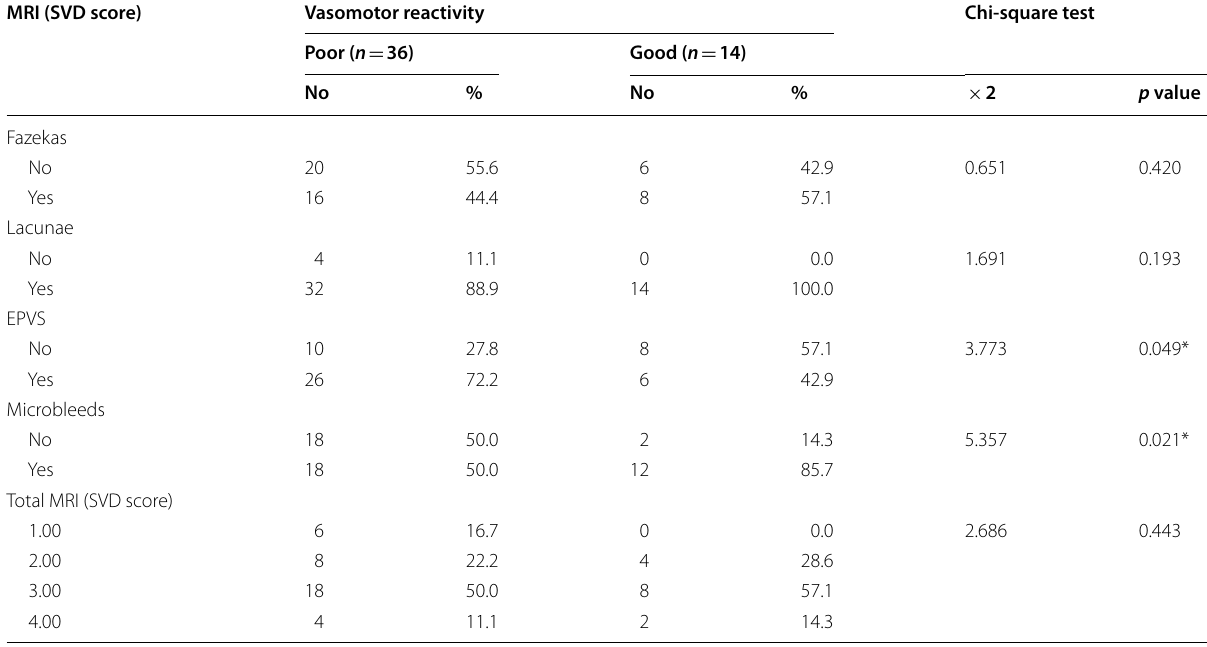
The asterisk denotes statistically significant value